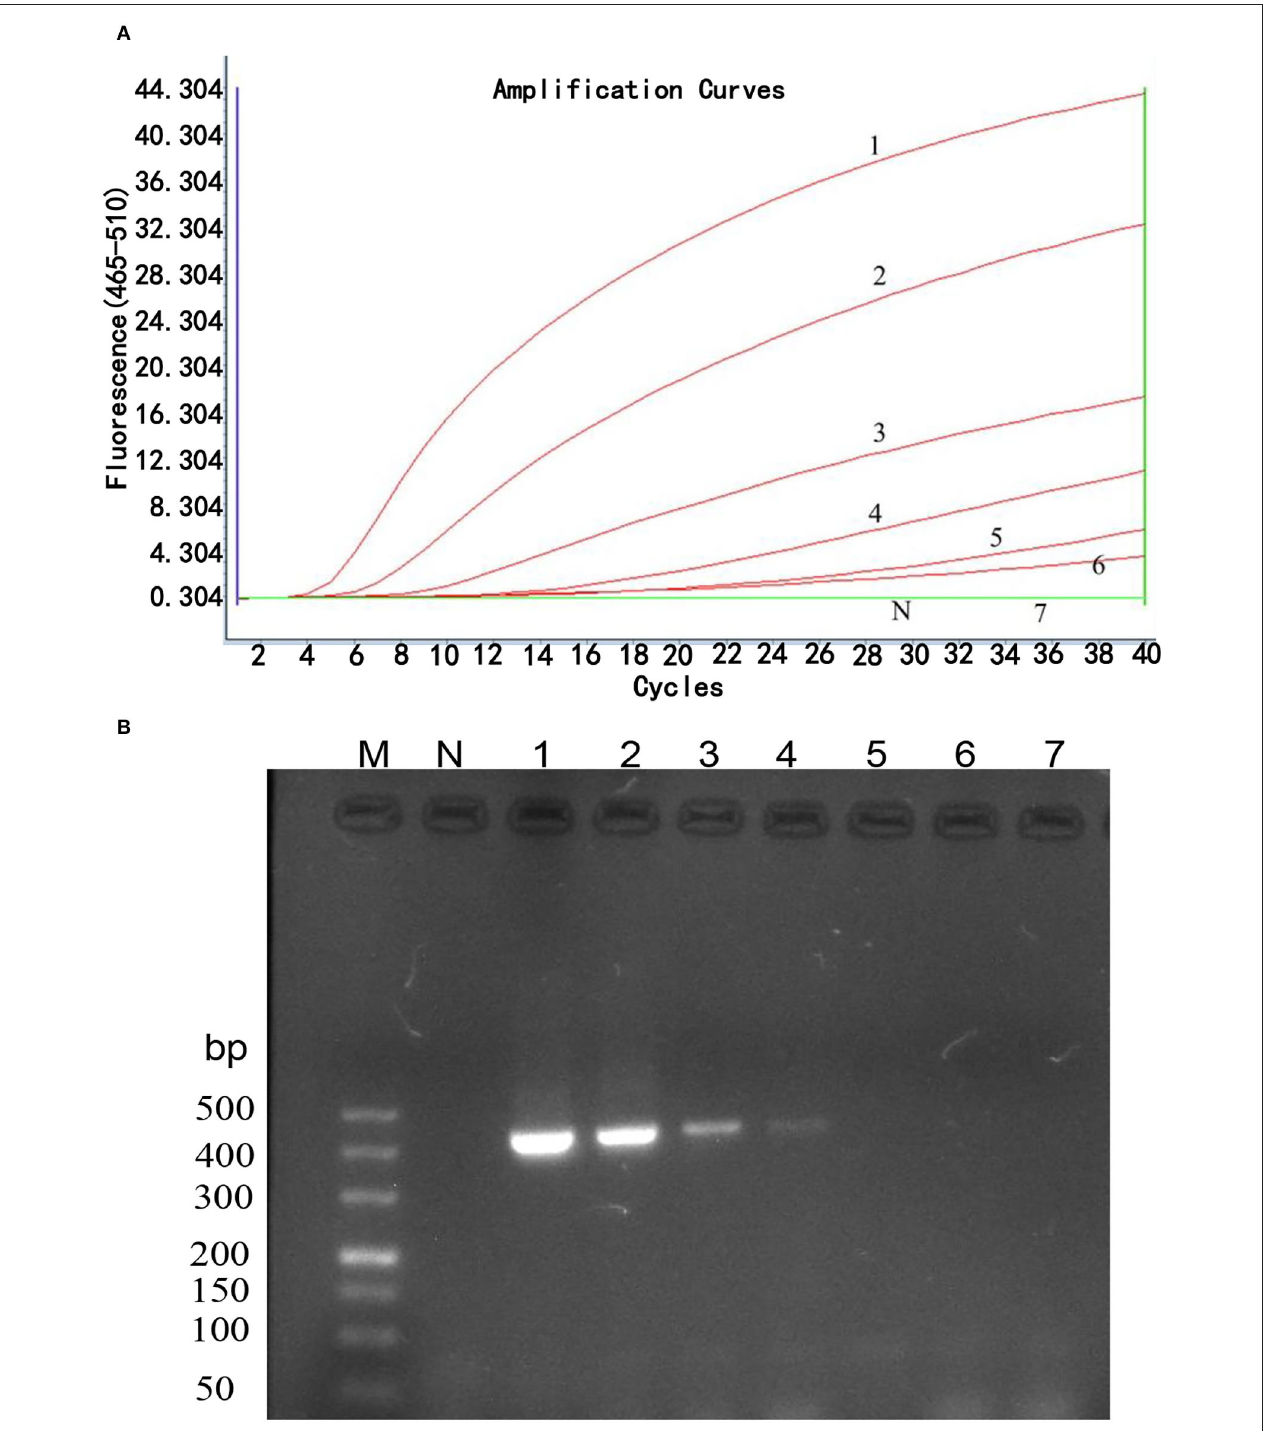
FIGURE 2 | Sensitivity analysis of real-time RPA assay. Serial dilutions of plasmid pMD18-gp85 DNA (10 6 -10 0 copies corresponding to curves 1–7) were used as the templates for real-time RPA reactions. (A) . Sensitivity analysis by LightCycler 480 Instrument II. The detection limit was 10 copies of DNA/reaction for the real-time RPA assay (curve 6). Reactions were scored positive when the change in fluorescence exceeded 1.0 units. Curve N used nuclease-free water as a negative control. (B) . Sensitivity analysis by electrophoresis. M: DL500 DNA marker; 1: 1 × 10 6 copies/ µ l; 2: 1 × 10 5 copies/ µ l; 3: 1 × 10 4 copies/ µ l; 4: 1 × 10 3 copies/ µ l; 5: 1 × 10 2 copies/ µ l; 6: 1 × 10 1 copies/ µ l; 7: 1 × 10 0 copies/ µ l.